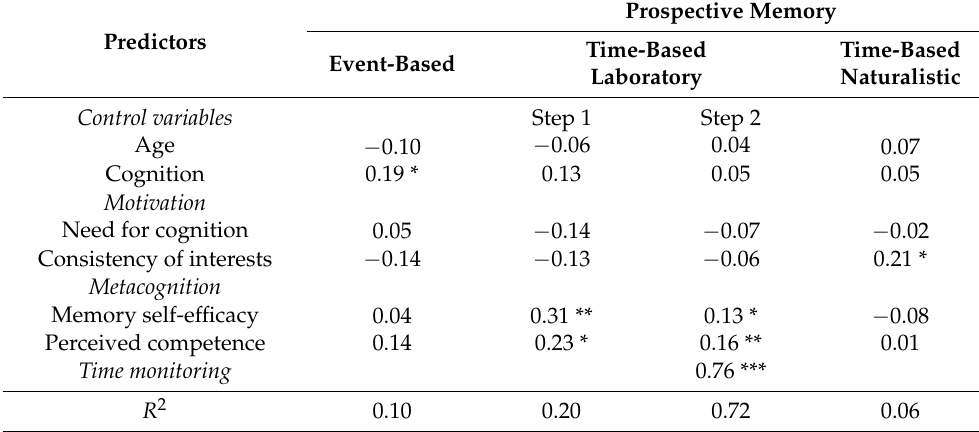
Table 2. Regression models predicting prospective